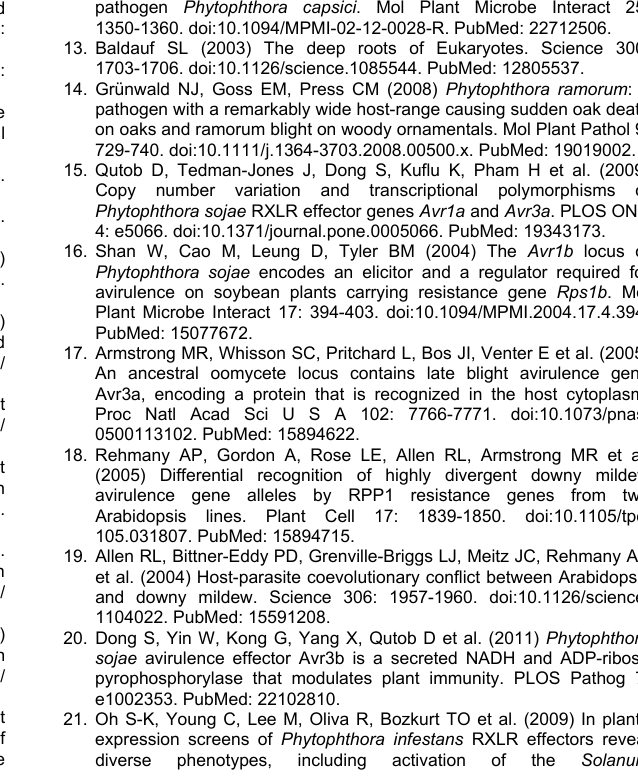
File S2. Nucleotide alignment of subfamily in Figure 1 in Fasta format.